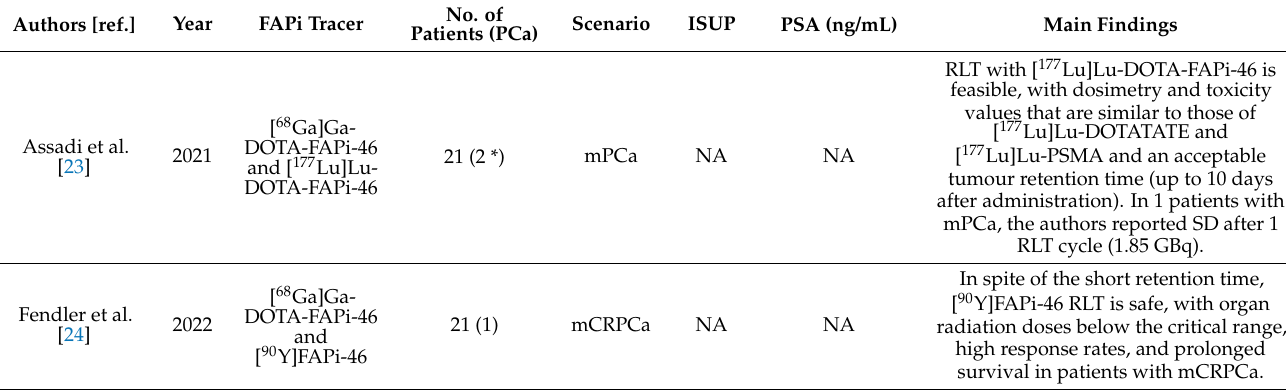
Table 4. R é sum é of the described studies on FAPi applications in PCa